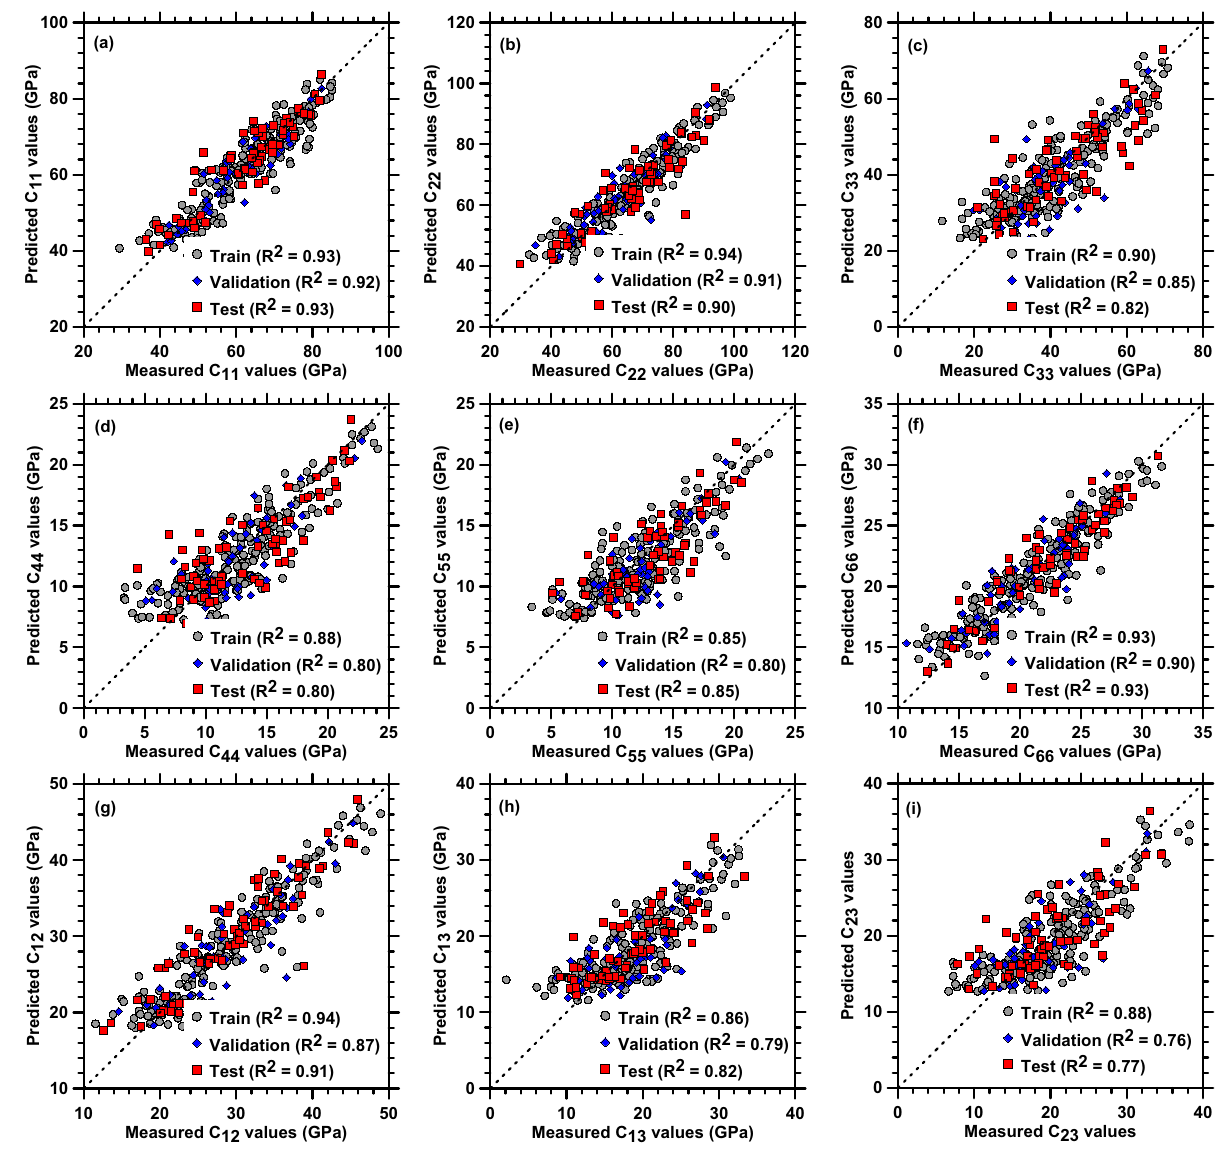
Figure 6. Comparison of the predicted elastic constants from NN (with number of neurons equal to 9) and measured values which are computed by MD